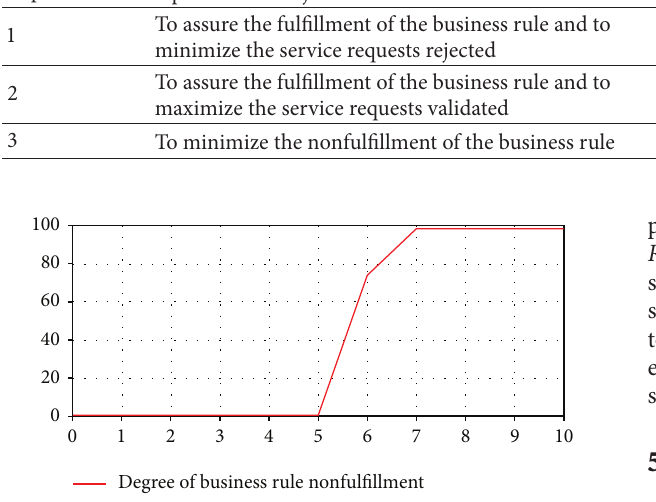
Figure 7: Output variable Business Rule Fulfillment